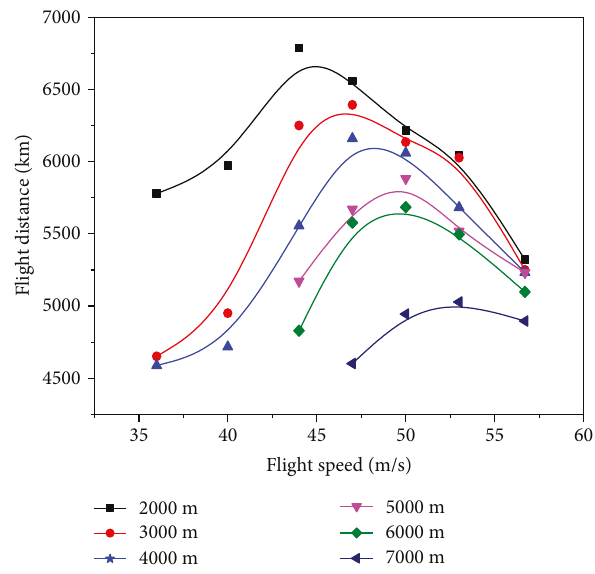
Figure 19: Flight envelopes of UAV.